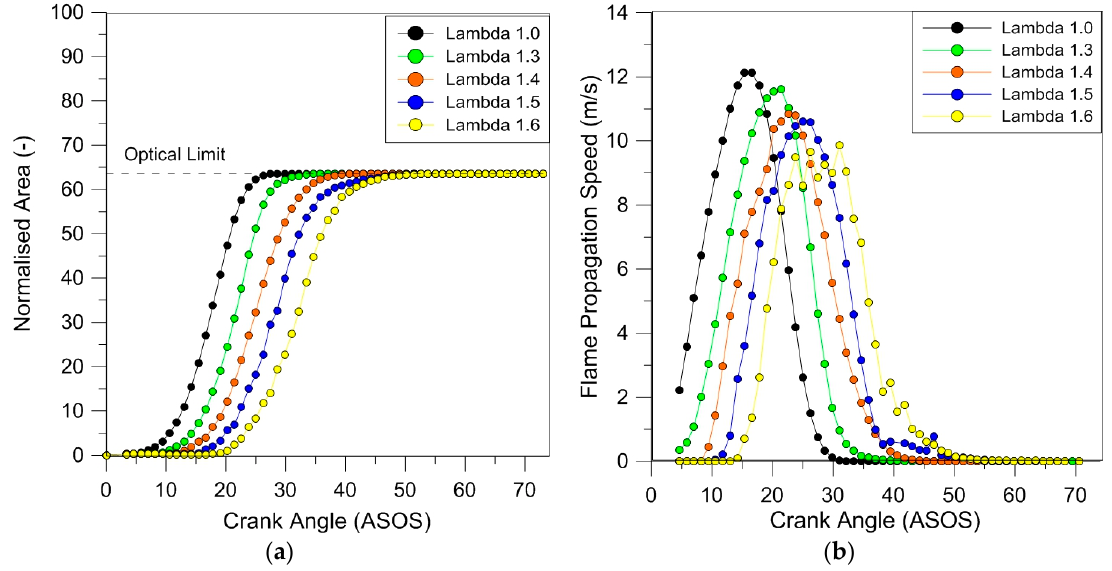
Figure 15. Evolution of ( a ) the flame front area and ( b ) related speed, both obtained by average data over 25 consecutive engine cycles.